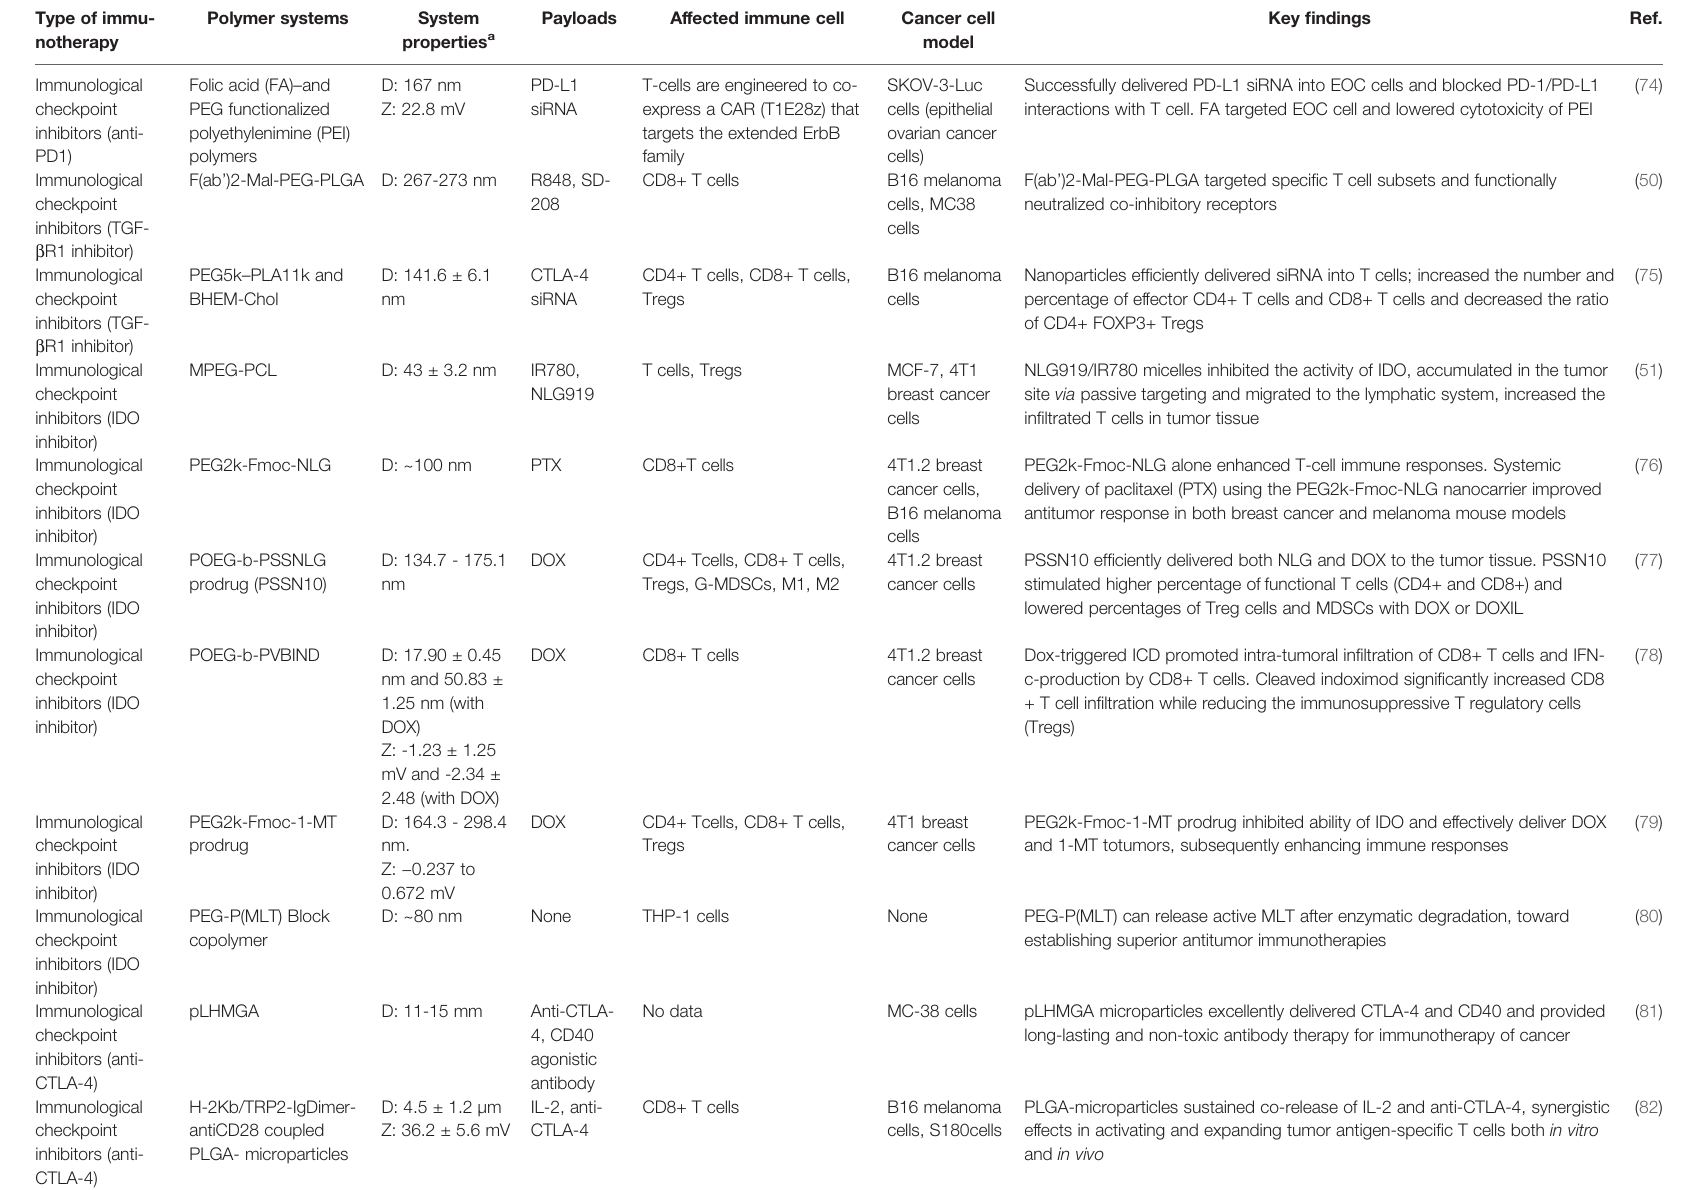
TABLE 1 | Summary of recent research on different polymeric systems for immunological checkpoint inhibitors.